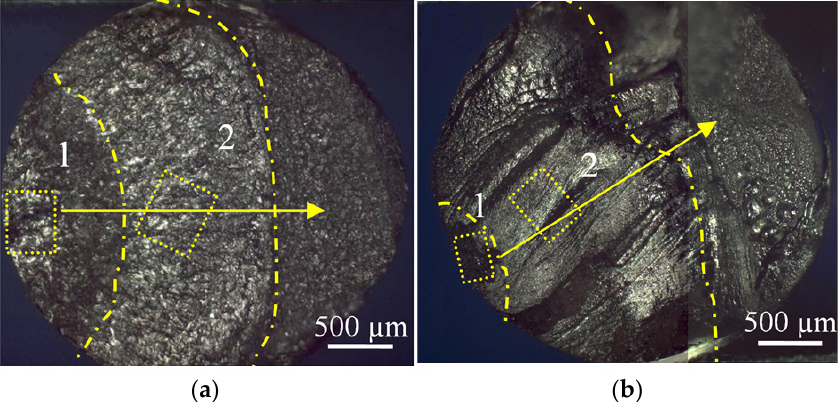
Figure 13. Optical micrographs of the fatigue fracture surface close to the initiation area (zone 1) and within the crack propagation zone (2) of ( a ) UFG and ( b ) CG Ti-45Nb alloy. The rectangles shown by dot lines indicate the selected areas for surface scanning. The solid arrows point the profile measurement direction, corresponding to fatigue crack distribution. The dash dot lines show boundaries of zones 1 and 2.